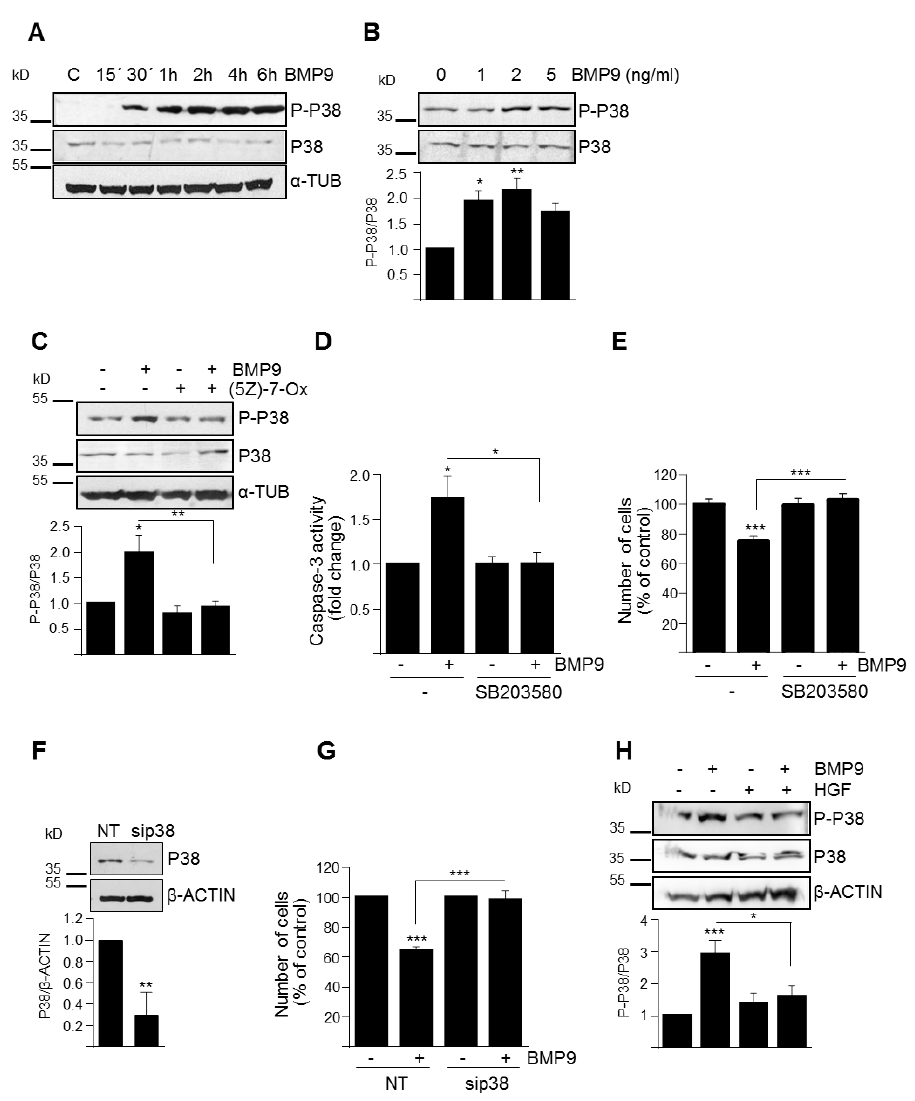
Figure 5. Activation of p38MAPK is required for BMP9-mediated oval cell death. A – C . Activation of p38MAPK by BMP9. Western blot analysis of P-P38 in Met flx / flx oval cells treated with BMP9 (2 ng / mL) for di ff erent periods of time ( A ); or treated for 30 min with di ff erent concentrations of BMP9 ( B ) or with BMP9 (2 ng / mL) ± (5Z)-7-oxozeaenol (0.5 µ M, 5Z-7-Ox) ( C ). A representive experiment of 3 is shown in each case. Optical density values are mean ± SEM of 3 experiments (bottom panels). D , E. P38MAPK inhibition impairs BMP9-induced apoptosis. Met flx / flx oval cells were treated with BMP9 (2 ng / mL) ± SB203580 (10 µ M). D . Caspase-3 activity was determined after 24 h. Data are mean ± SEM of 3 experiments run in duplicate. E . Cells were counted at day 2. Data are mean ± SEM. of 3 experiments run in triplicate. F , G . Knockdown of p38MAPK impairs BMP9-induced cell death. Met flx / flx oval cells were transiently transfected with non-targeting control siRNA (NT) or p38 targeting siRNA (sip38). F . Western blot analysis of P38 levels. A representative experiment of 3 is shown (upper panel). Optical density values are mean ± SEM of 3 experiments (bottom panel). G. Oval cells (NT and sip38) treated with BMP9 (2 ng / mL) were counted at day 2. Data are mean ± SEM of 3 experiments run in triplicate. H . HGF inhibits BMP9-triggered p38MAPK activation. Western blot analysis of P-P38 in Met flx / flx oval cells treated for 30 min with BMP9 (2 ng / mL) ± HGF (40 ng / mL). A representative experiment is shown (upper panel). Optical density values are mean ± SEM of 6 experiments (bottom panel). Data were compared with the untreated group or as indicated, * p < 0.05, ** p < 0.01, *** p <